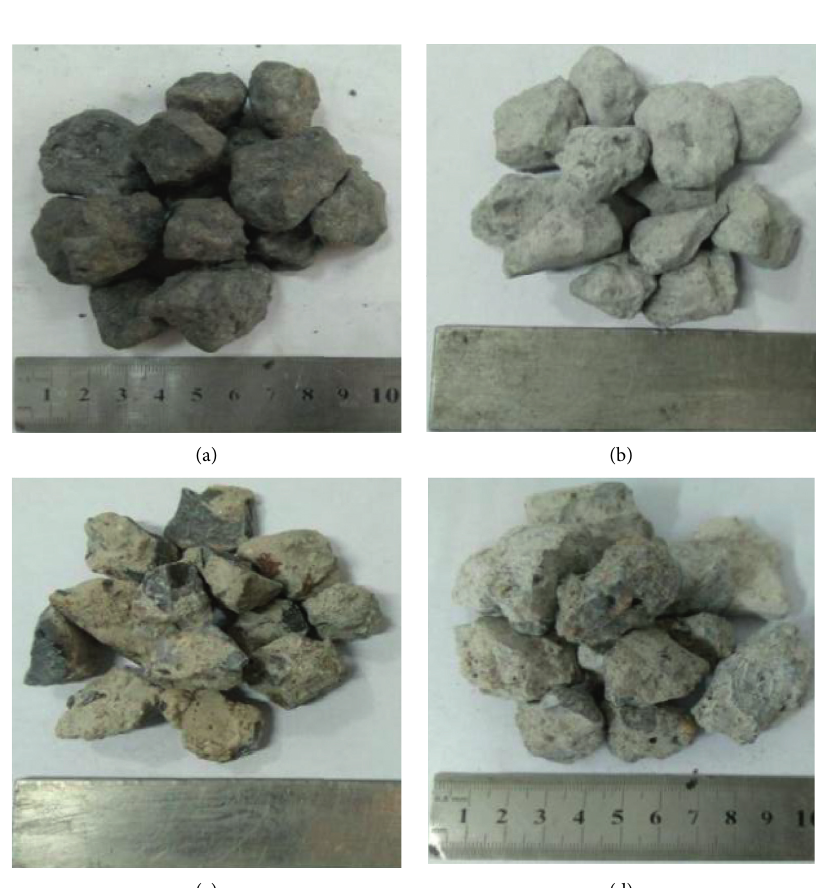
Figure 3: Appearance of RA after chemical enhancing-technology. (a) C-3 method. (b) C-7 method. (c) N-P method. (d) H